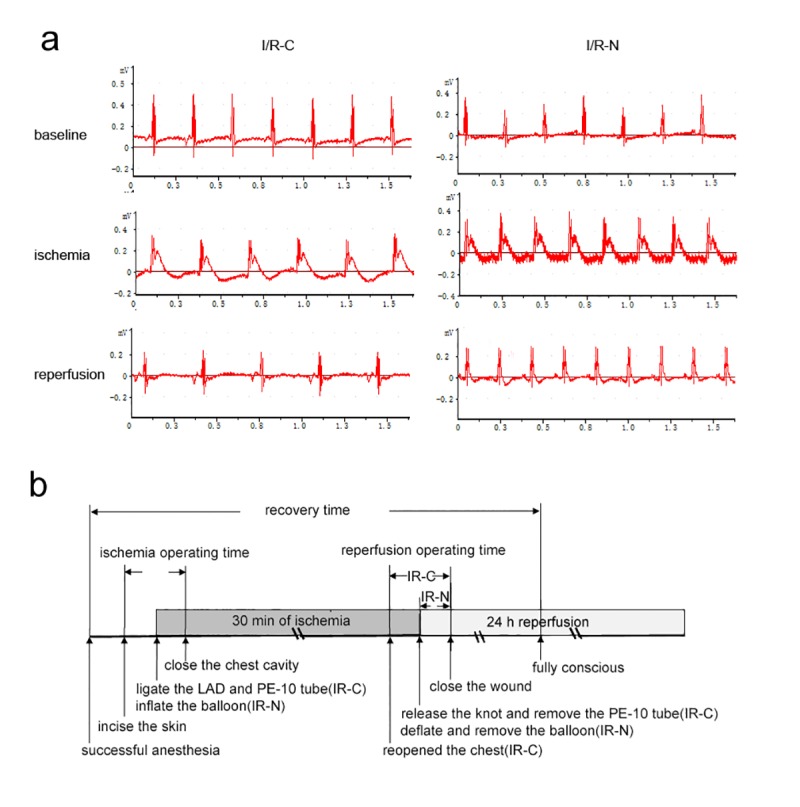
Representative electrocardiogram during different period and a schematic diagram of surgical procedure.a. Electrocardiogram changes during I/R. Before ligation of the LAD, the ST segment was located at the baseline. The ST segment elevated during ischemia and it declined in reperfusion period. b. The schematic diagram of surgical procedure, recovery time, ischemia operating time and reperfusion operating time.